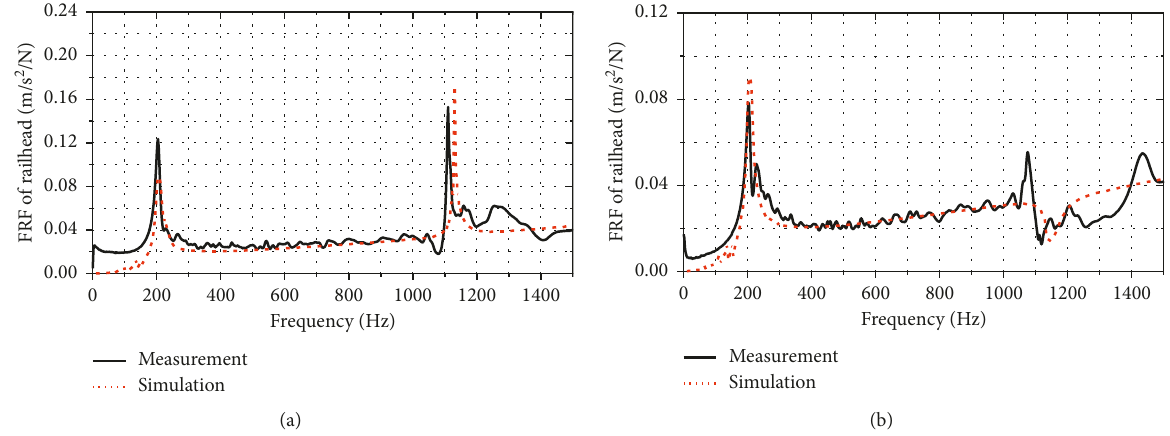
Figure 9: Comparison of measured and calculated vertical FRFs of the track system: (a) FRFs of the railhead at the midspan between two sleepers; (b) FRFs of the railhead over the sleeper.